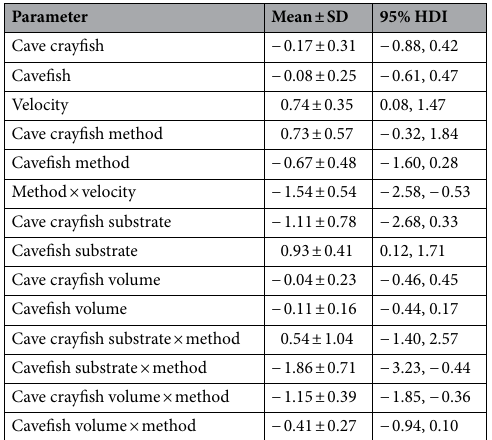
Table 2. Estimated detection probability of cavefishes and cave crayfishes in relation to sampling method and environmental covariates derived from an occupancy model. HDI highest density